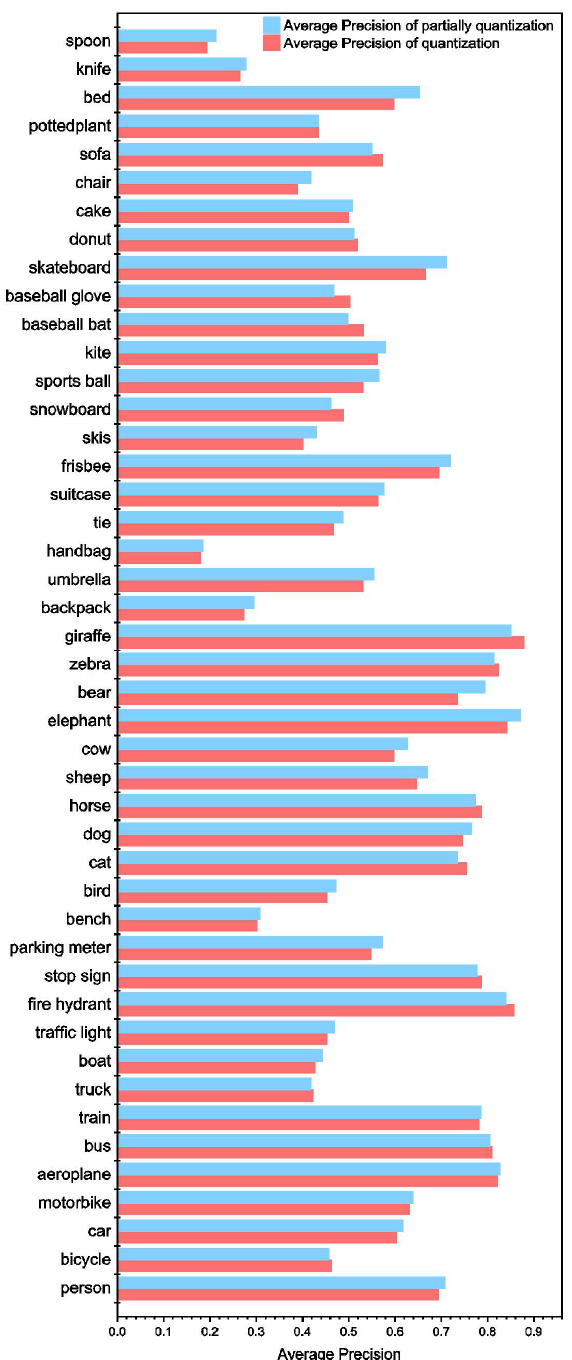
Figure 10. Comparison of average precision between fully quantized model and the partial quantized model for different series in COCO